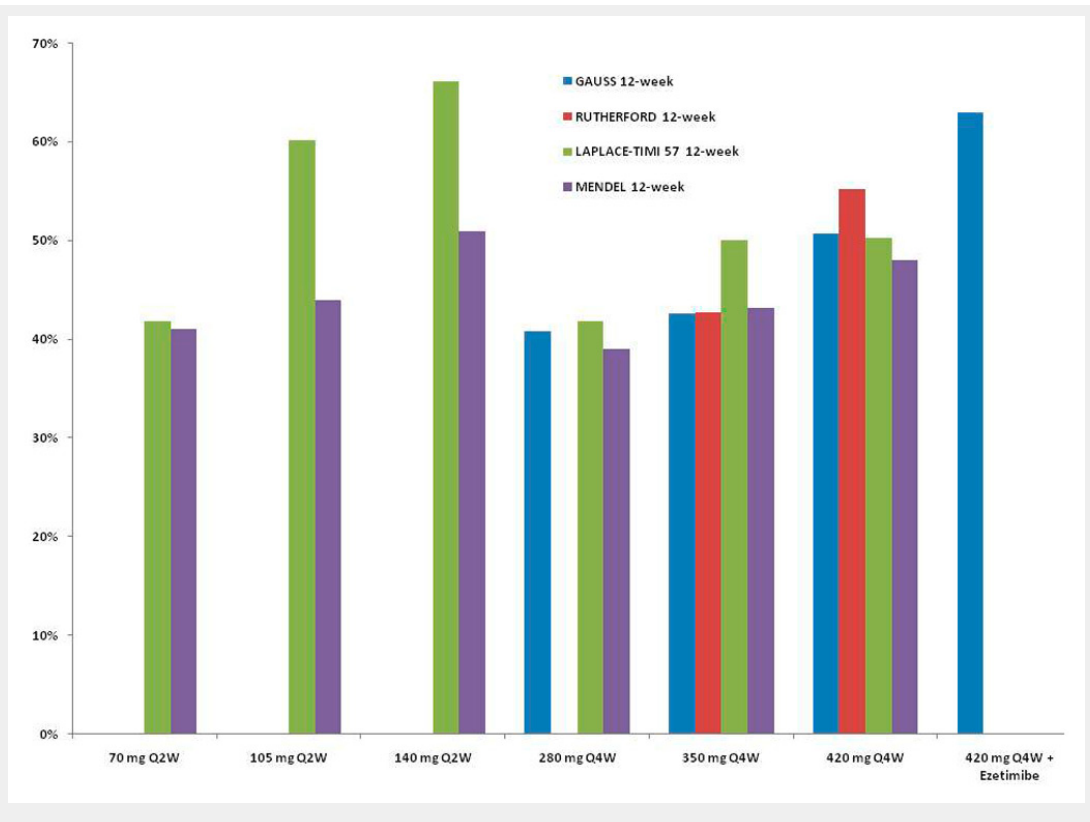
Figure 2 Mean percent decrease from baseline in low-density lipoprotein (LDL) cholesterol levels with the AMG 145 regimen. Results were derived from GAUSS [18], RUTHERFORD [21], LAPLACE-TIMI 57 [19] and MENDEL